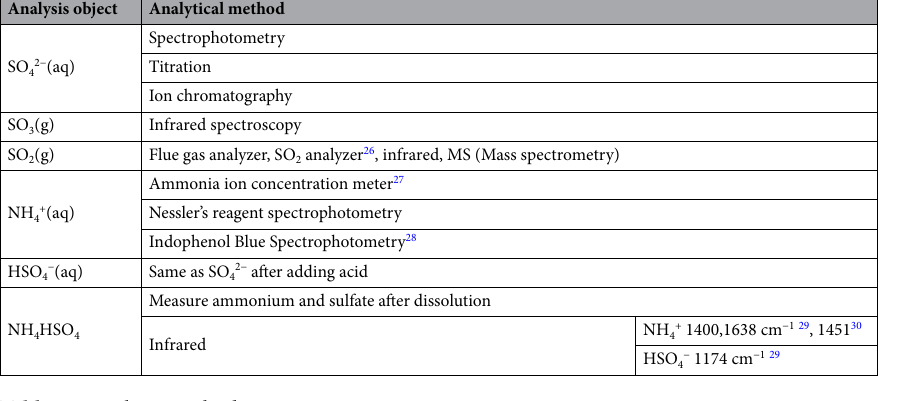
Table 3. Analysis